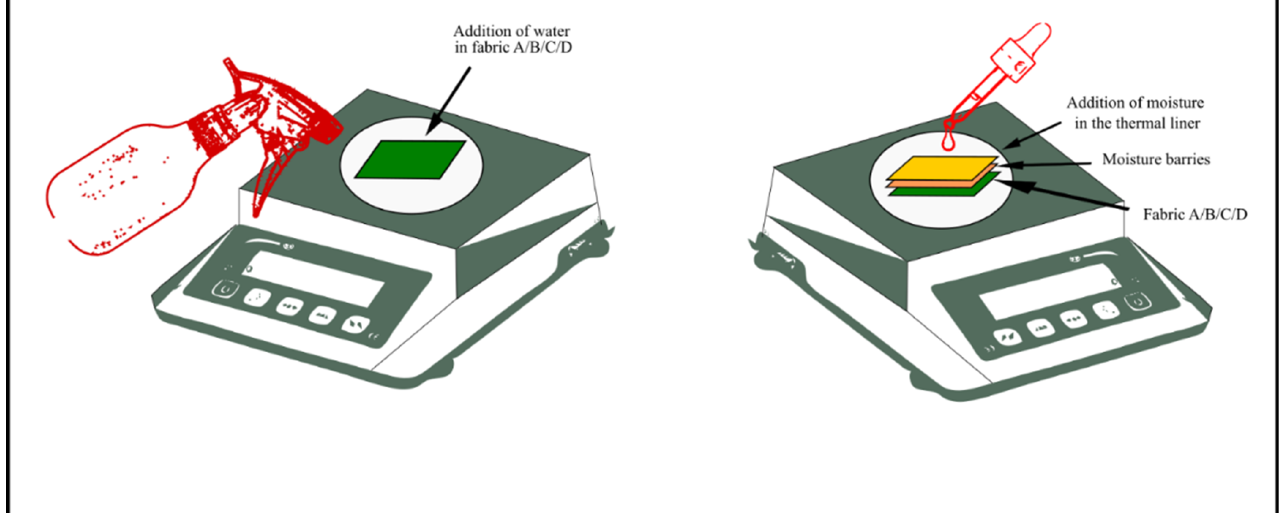
Figure 2. Schematic diagram of addition of water in the fabrics by spray and dropper